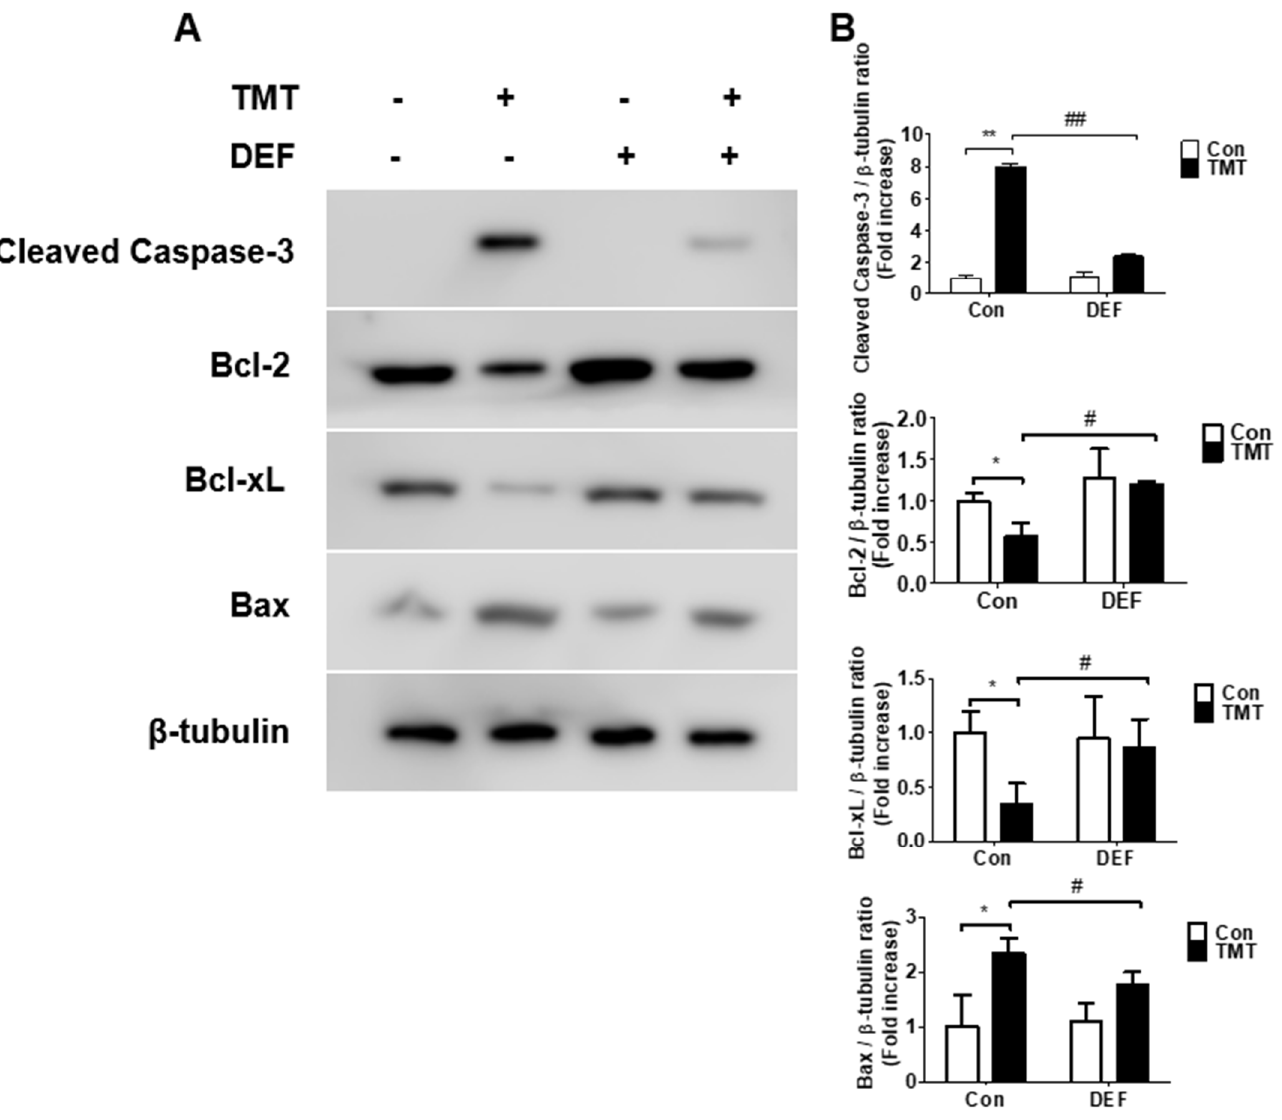
Figure 4. ( A ) Alterations of cleaved caspase-3, Bcl-2, Bcl-xL, and Bax levels induced by 10 μ M TMT were determined by Western blot analysis. β -tubulin was used as a control. Deferoxamine showed significant inhibition of TMT-induced alteration of apoptosis and antiapoptosis proteins. ( B ) Histogram showing quantitative densitometric analysis. * p < 0.05 and ** p < 0.01 ( n = 3), compared to vehicle (DMSO)-treated group. # p < 0.05 and ## p < 0.01 ( n = 3), compared to TMT-treated group. Experiments were performed at least three times, with similar results. Con: control, DEF: deferoxamine, DMSO: dimethyl sulfoxide.